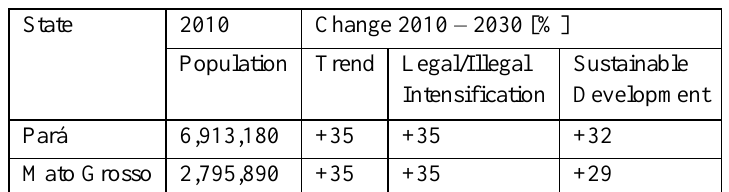
Table A1.5. Population development in Pará and Mato Grosso; population numbers in 2010 and change rates until 2030.